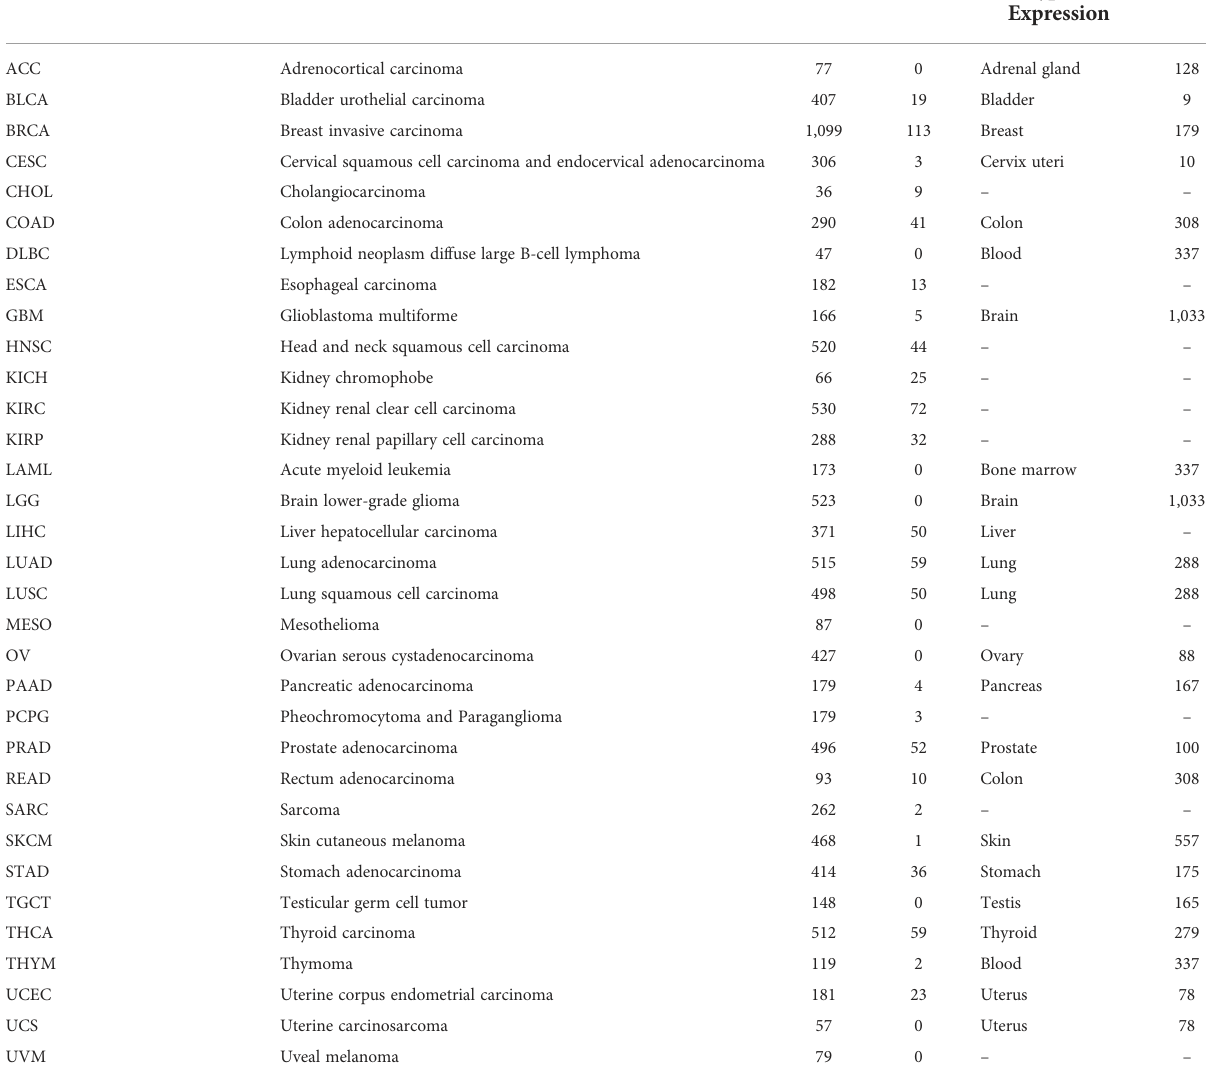
TABLE 1 Basic information of the 33 tumors and matched normal tissues. The Cancer Genome Atlas